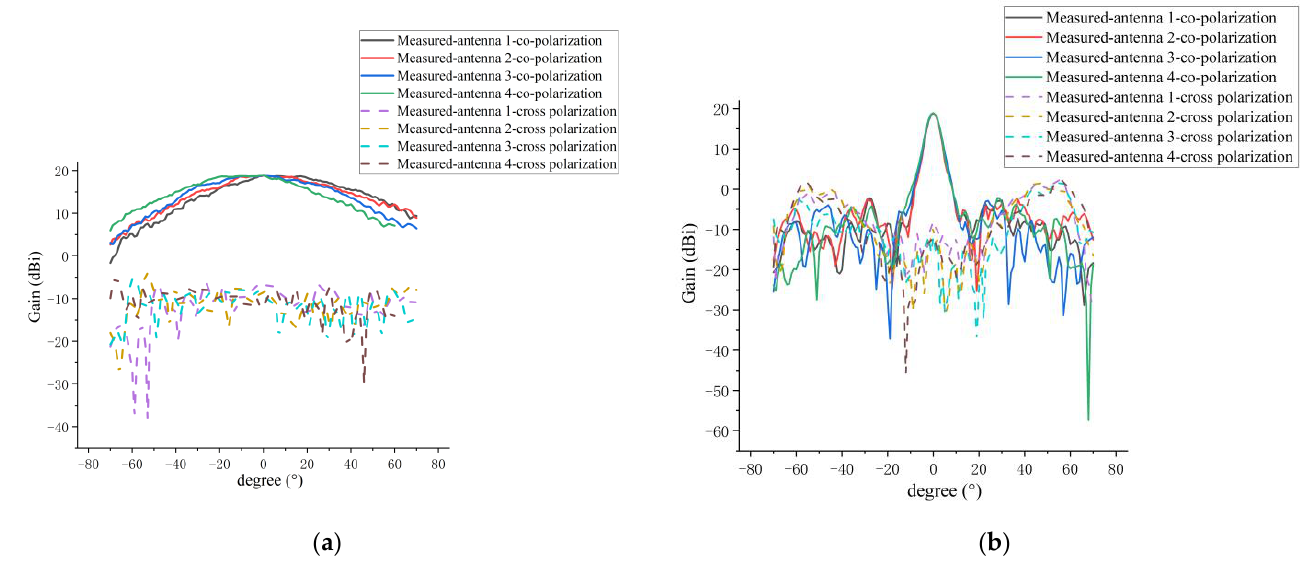
Figure 21. Measured amplitude pattern of 3-dB beamwidth for every antenna element in sparse arra:y ( a ) E-plane pattern; ( b ) H-plane pattern. Table 5. Measured results of E- and H-plane patterns for every antenna element in sparse array.